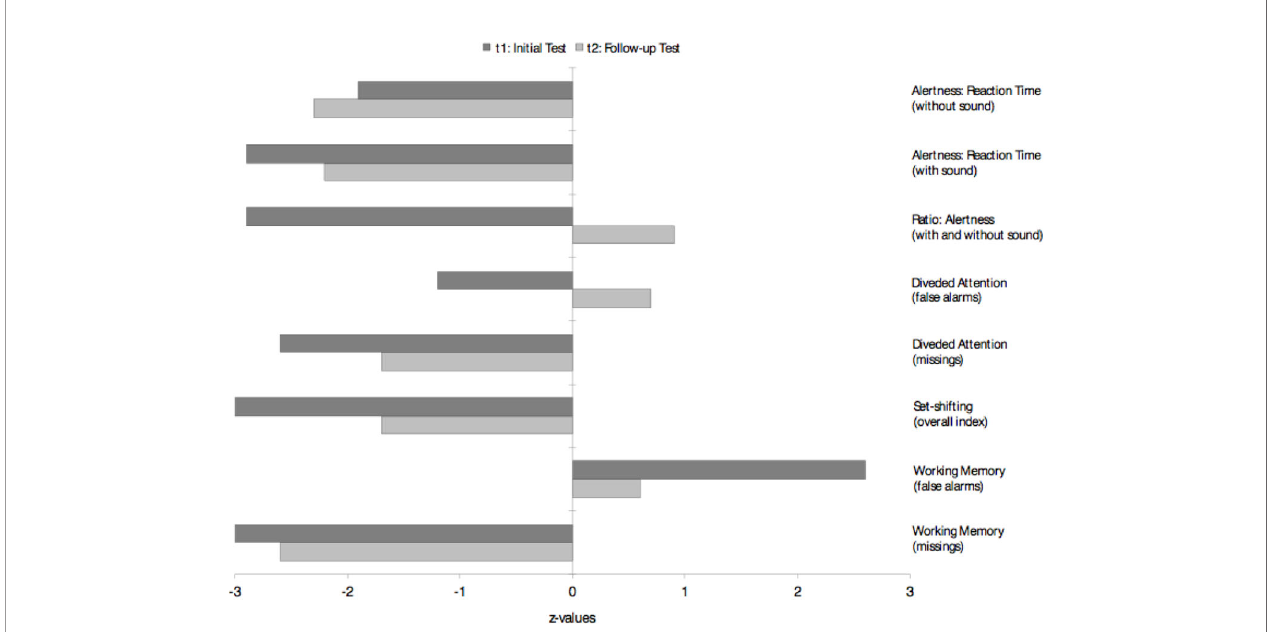
FIGURE 4 | Comparison between initial (2010) and follow-up (2019) neuropsychological fi ndings. The fi ndings predominantly improved, but remain mainly still below